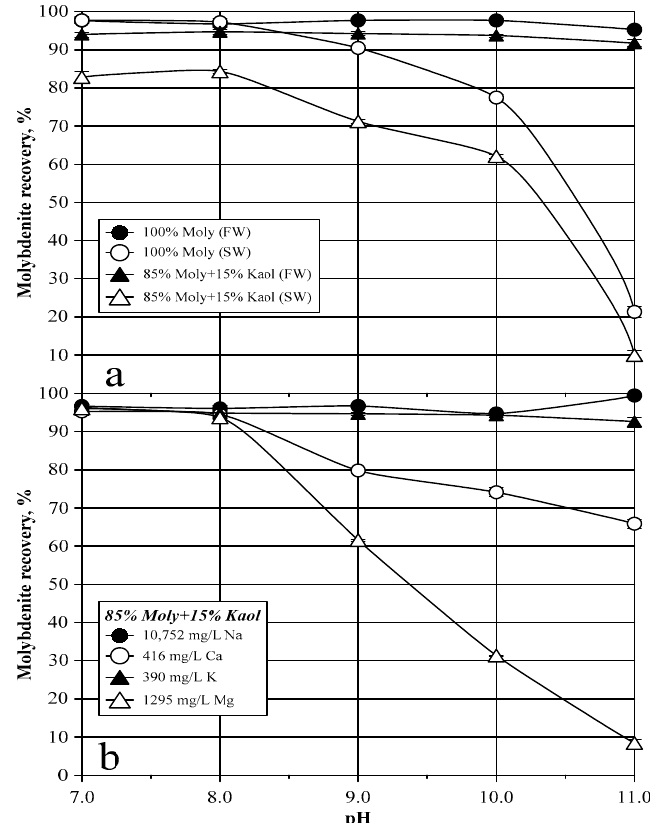
Figure 1. Recovery of molybdenite in the absence and presence of 15% kaolinite as a function of pH in different aqueous solutions, i.e., ( a ) fresh (FW) and seawater (SW), and ( b ) solutions of 10,752 mg/L Na, 390 mg/L K, 416 mg/L Ca, 1295 mg/L Mg. Moly: molybdenite; kaol: kaolinite.